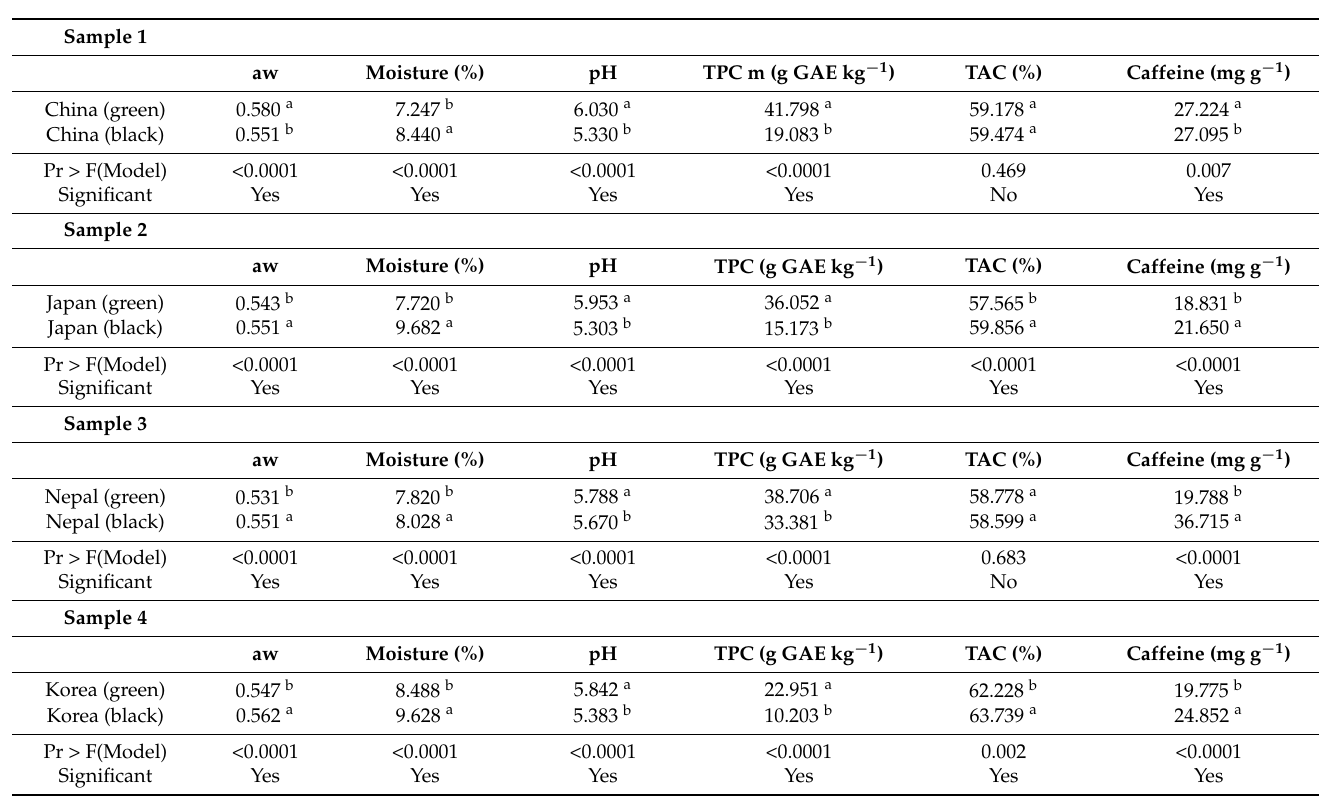
Table 4. ANOVA Duncan and REGWQ comparison of selected parameters of individual samples in relation to the fermentation process.